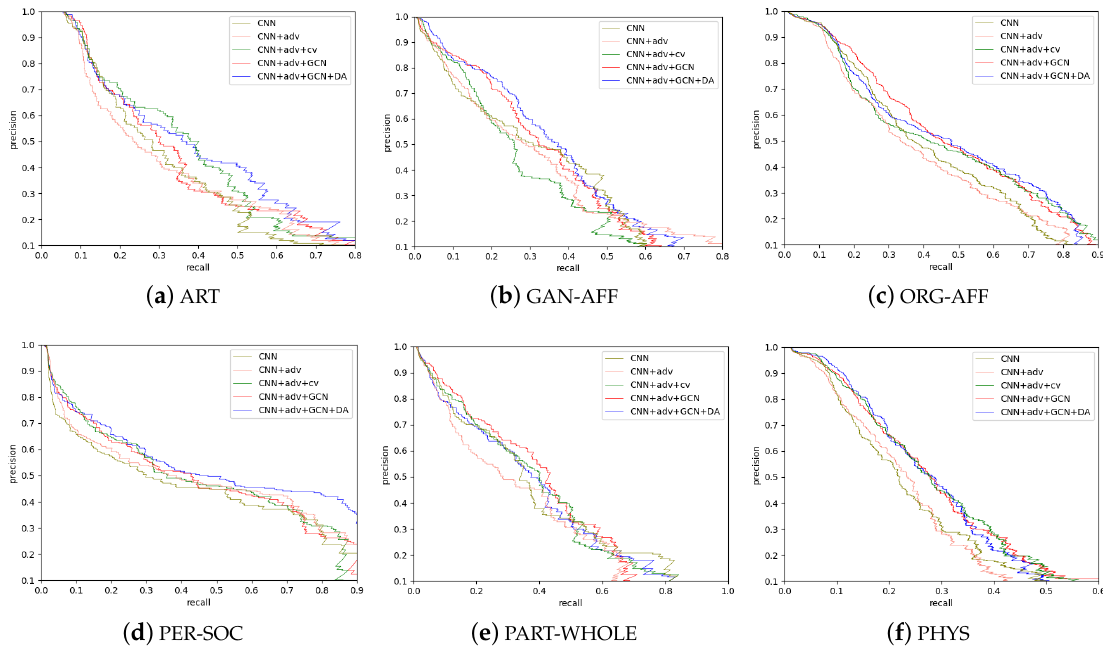
Figure 10. Precision/recall curves under different relation types.